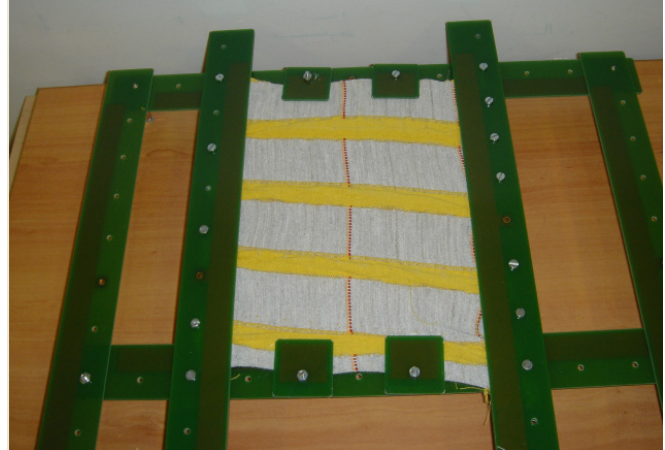
Figure 3. Photograph of fabric on the test bank.